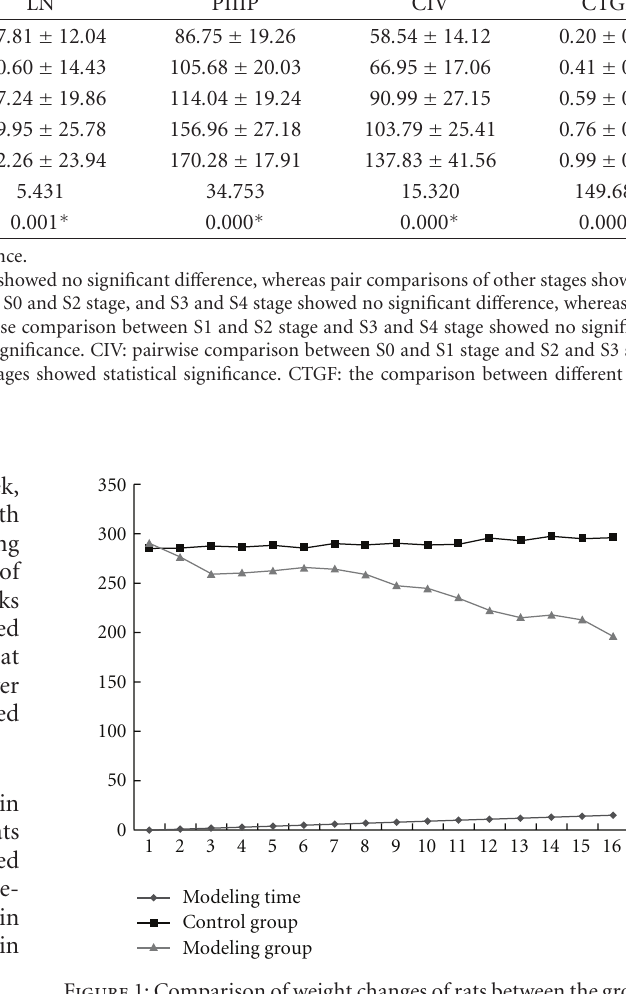
Figure 1: Comparison of weight changes of rats between the groups in each